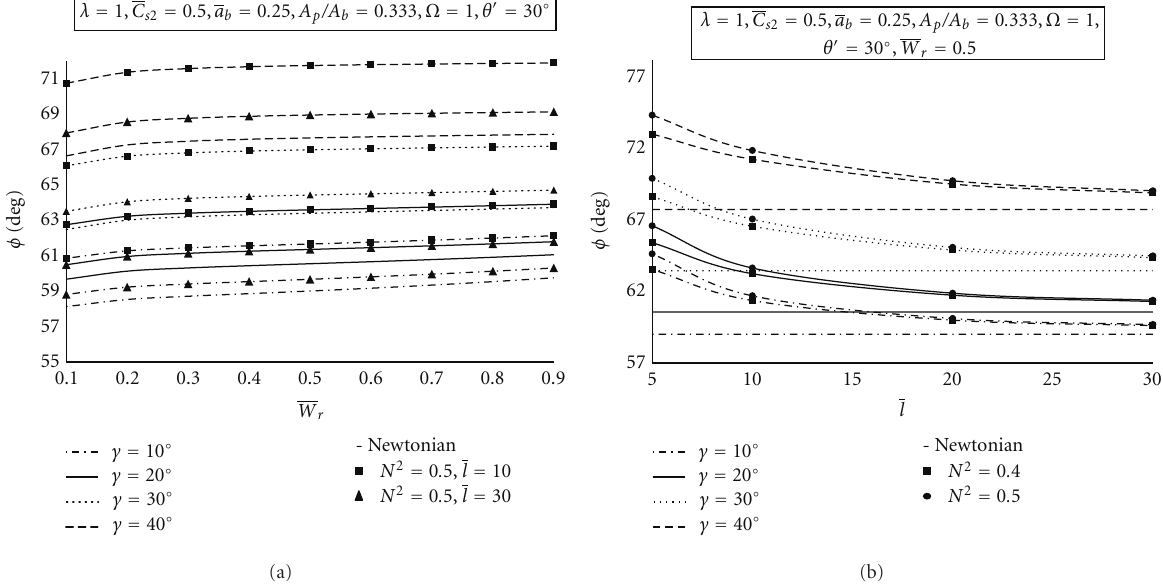
Figure 5: (a) Variation of attitude angle ( φ ) versus radial load ( W r ). (b) Variation of attitude angle ( φ ) versus characteristic length ( l ).